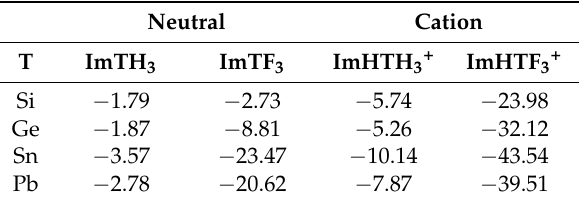
Table 1. Binding energy (kcal/mol) between Cl − and ImTR 3 and ImHTR 3+ .